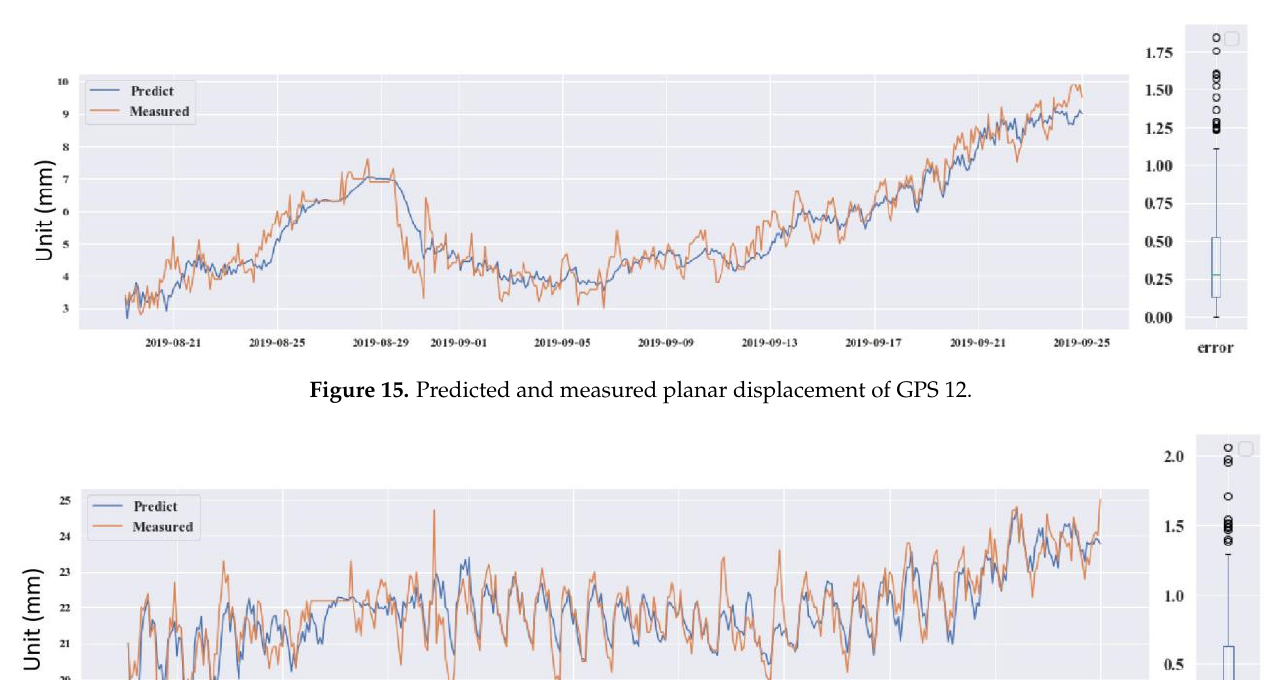
Figure 14. Predicted and measured planar displacement of GPS 06.